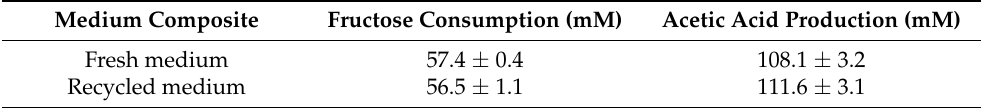
Table 1. Comparison of the fermentation profile of A. woodii using a fresh medium and a reused medium after treatment with